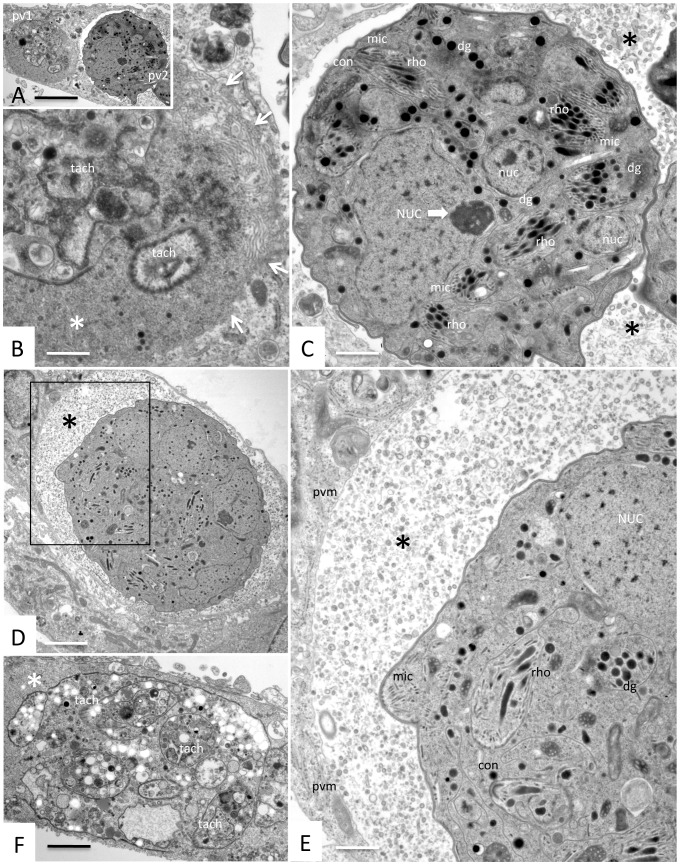
TEM analysis of N. caninum-infected HFF cultures in the presence of 2.5 μM of inhibitor 1294 for 5 and 9 days.
A–C illustrate two distinct outcomes of treatment with 2.5(PV1 and PV2) in a HFF cell. In B, the higher magnification view of PV1 reveals non-viable remnants of tachyzoite (tach), now largely embedded in a solid matrix (*), and as indicated by arrows, the parasitophorous vacuole membrane has been replaced by a rather amorphous transition zone between PV1 and the host cell cytoplasm. In C, PV2 displays a complex of still viable and presumably proliferating, but non-separating, parasites forming a large multi-nucleated mass, with clearly discernable micronemes (mic), rhoptries (rho), dense granules (dg), and smaller nuclei (nuc). Note the large nuclear mass (NUC) in the center with a large nucleolus marked by the bold arrow. In D, and at a higher magnification in E, a similar multinucleated complex is shown after 9 days of treatment with compound 1294, also displaying a large nuclear mass (NUC), as well as rhoptries, micronemes, dense granules, and an intact parasitophorous vacuole membrane. In F, a non-viable complex with tachyzoite remnants (tach) is shown after 9 days of treatment. Note the difference in electron density of the matrix of PVs containing non-viable parasites (B, F) compared to viable multinucleated complexes (C, D, E). Bars in A = 5 μm; B = 0.8 μm; C = 0.9 μm; D = 2 μm; E = 0.7 μm; F = 0.9 μm.